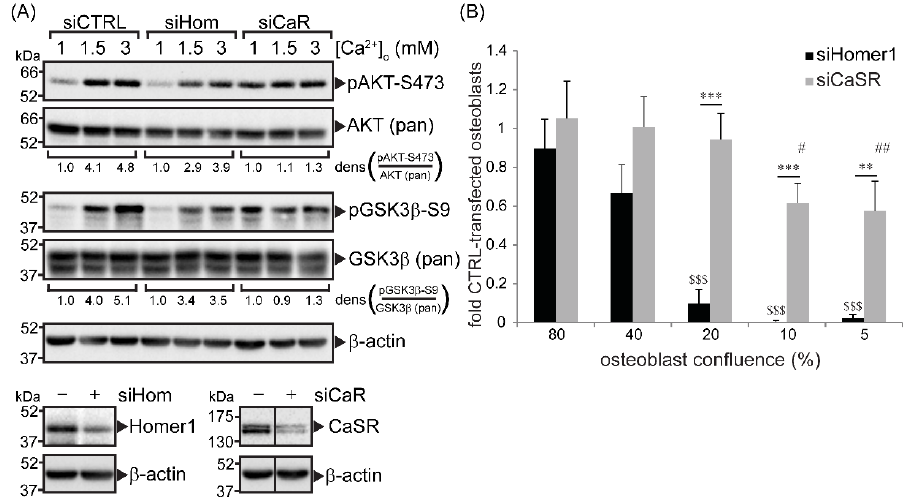
Figure 1. Calcium-sensing receptor (CaSR) and Homer1 modulated extracellular Ca 2+ -dependent phosphorylation of AKT and glycogen synthase kinase-3 (GSK3) and cell viability in human osteoblasts. ( A ), top: Western blot showing the level of phosphorylated AKT (S473), total AKT, phosphorylated GSK3 (S9), total GSK3 and β -actin (loading control) in response to extracellular Ca 2+ concentrations for 15 min in simian virus 40 (SV40)-immortalized primary human osteoblasts. Prior to Ca 2+ treatment, cells were transfected with siRNA targeted at Homer1 (siHom), CaSR (siCaR) or a non-directed sequence (siCTRL) for 48 h. Densitometric values (dens) were calculated (Image J) by expressing the value obtained for phosphorylated protein by the total protein for each treatment and normalizing this number to the ratio obtained from the 1 mM Ca 2+ lane for each silenced condition (vehicle treatment). ( A ), bottom: Western blot showing the protein level of Homer1 and CaSR in response to each targeted siRNA (+) compared with cells transfected with non-directed sequence (-) in immortalized primary human osteoblasts. Solid, vertical black lines on the presented Western blotting ( CaSR blot only) indicate where lanes have been spliced from the same Western blotting for presentation purposes. ( B ) Primary human osteoblasts were plated to achieve the indicated degree of confluence after 24 h. Cells were subsequently transfected with siRNAs directed against Homer1, CaSR or a non-directed sequence. Following a further 48 h culture, cell viability was quantified using the resazurin dye CellTiterBlue™. The data are presented as fold viabilities with respect to the viability of osteoblasts transfected with the non-directed sequence. $$$ p < 0.001 compared to cells at 80% confluence transfected with siHomer1; # p < 0.05, ## p < 0.01 compared to cells at 80% confluence transfected with siCaSR; ** p < 0.01, *** p < 0.001 compared as indicated with horizontal line.